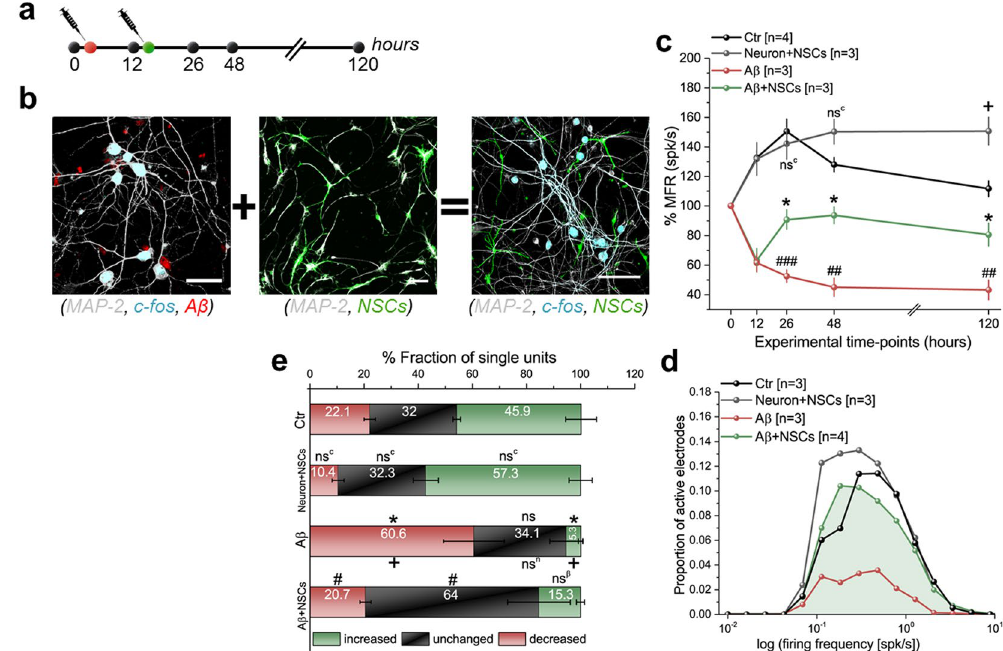
Figure 5. Cell-based therapeutic strategy using neural stem cells (NSCs) to reverse A β -induced neurotoxicity on CMOS chips. ( a ) Schematic of therapeutic treatment using NSCs administration on-chip 12 h after 0.1 µ M A β . ( b ) Confocal micrographs of diseased neuronal culture ( left ), network of NSCs ( middle ), and mixed populations of matured neurons and NSCs ( right ). Scale bars represent 50 μ m. ( c ) On-chip MFR upon rescuing therapy using NSCs monitored for 120 h. * Denotes p < 0.05 compared to A β ; # and + denote p < 0.05 compared to control, ANOVA. ns c denotes not significant compared to control. ( d ) Lognormal-like distributions after 48 h recording corresponding to rescuing strategy in ( a ). p < 0.05, Kolmogorov-Smirnov test for rescued networks (A β + NSC) versus diseased networks (A β ). ( e ) Quantification of single-unit analysis for NSCs rescue strategy, * and + denote p < 0.05 compared to control and Neuron + NSCs, respectively. # Denotes p < 0.05 compared to A β , ANOVA. ns, ns β , and ns c denote not significant compared to control, Neuron + NSCs, and A β ,